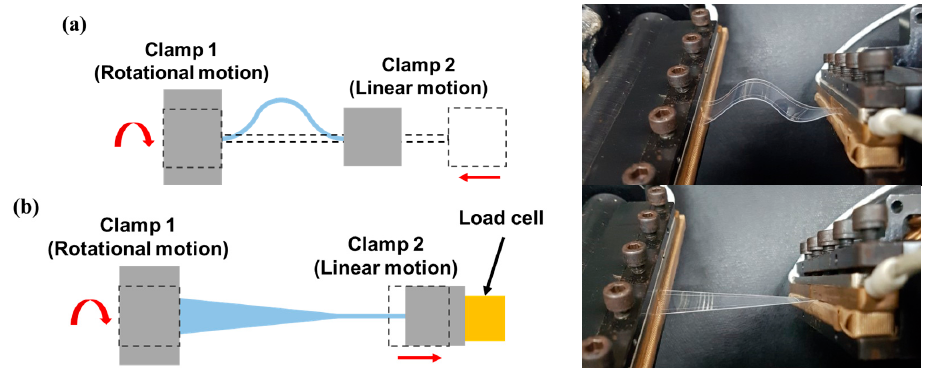
Figure 9. Schematics and actual photographs of complex deformation modes: ( a ) twisting and bending; ( b ) twisting and stretching.